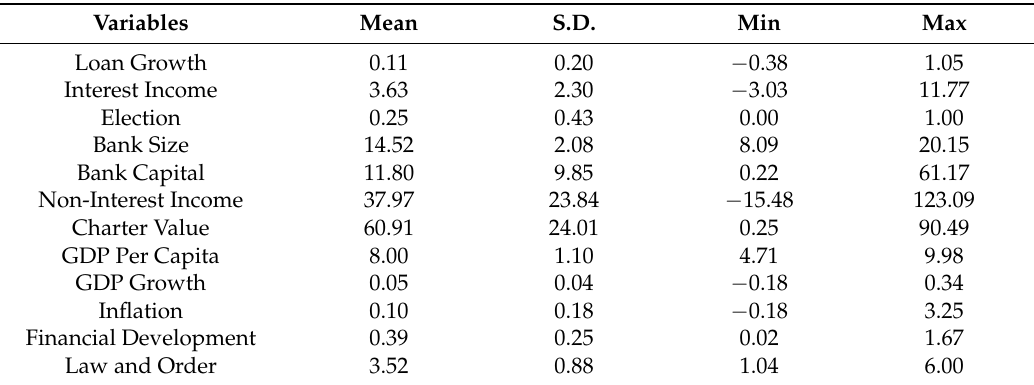
Table 2. Summary